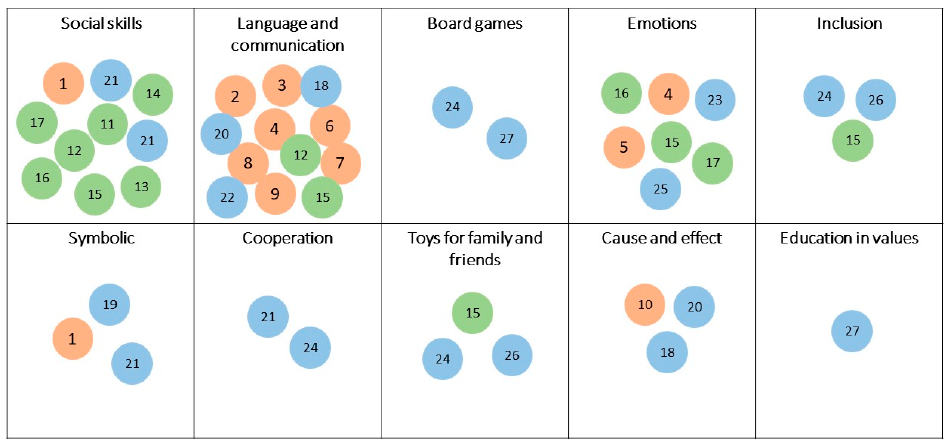
Figure 10. The results are shown in Figure 10; the different colored circles differentiate the types of products: orange “applications and virtual environments”, green “robots”, and blue “toys”. The numbers correspond to the ones on Tables 15–17.